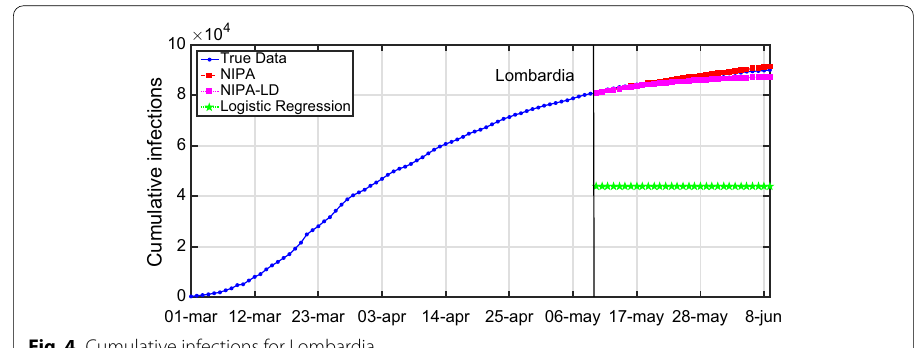
Fig. 4 Cumulative infections for Lombardia